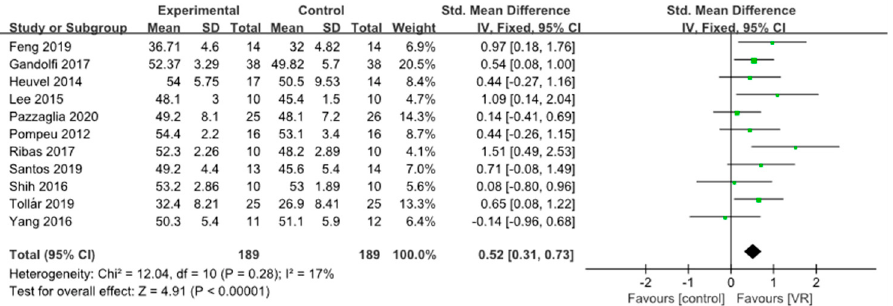
Figure 4. Meta-analysis results for Berg balance scale (BBS).